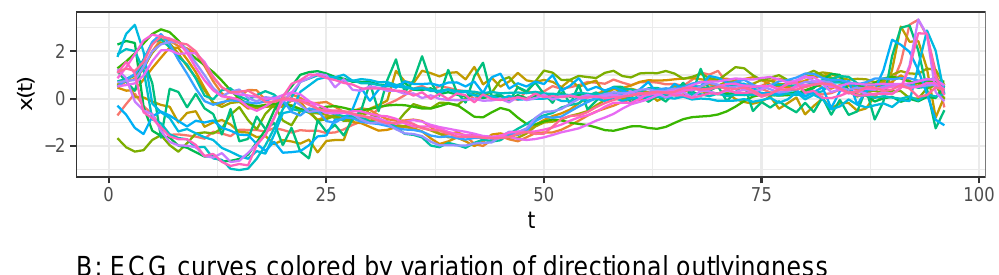
B: ECG curves colored by variation of directional outlyingness